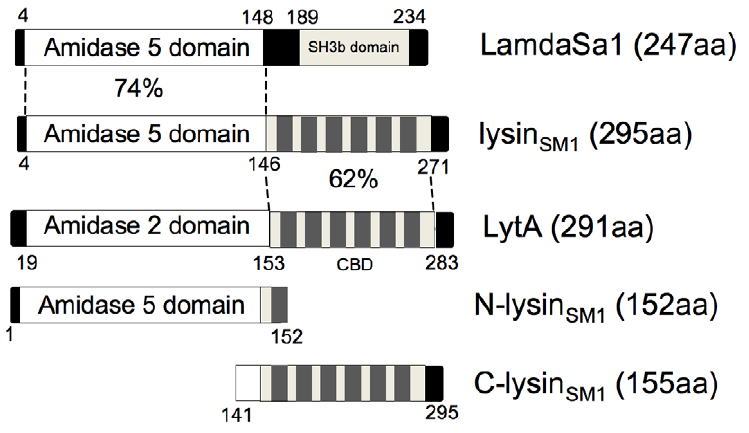
Figure 1. Domain organization of lysin SM1 and its homologs. Domains of lysin SM1 are compared with its closest homologs, the lambdaSa1 phage lysin of Streptococcus agalacitae and the LytA autolysin of Streptococcus pneumoniae , using the NCBI BLAST search program. Levels of identity between regions are indicated. Also shown are the alignments of the amino (N-lysin SM1 ) and carboxyl terminal (C-lysin SM1 ) truncated form of lysin SM1 . CBD: choline-binding domain. SH3b: putative bacterial cell wall-binding